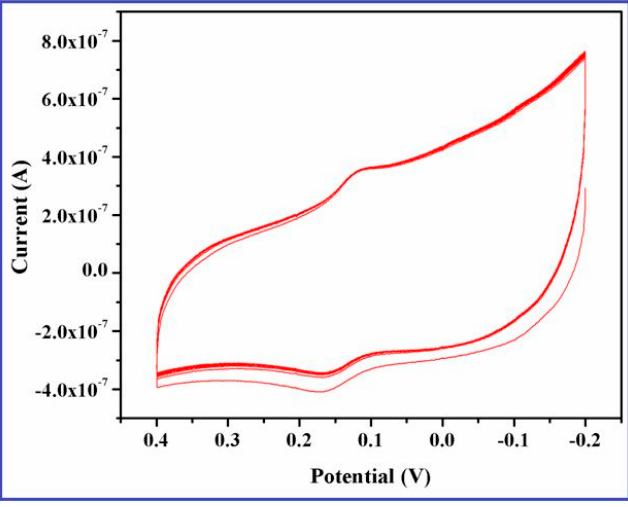
Figure 12. Fifty repeated CV scans of the CuO nanowires/GCE in 0.2 mM DA at a scan rate 50 mV/s.